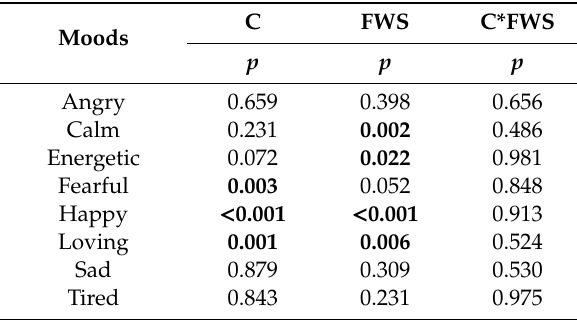
Table A2. Results of the Repeated Measures ANOVA investigating e ff ects of context (C) and Fine Wine Segment (FWS) on consumers moods in Study 2.